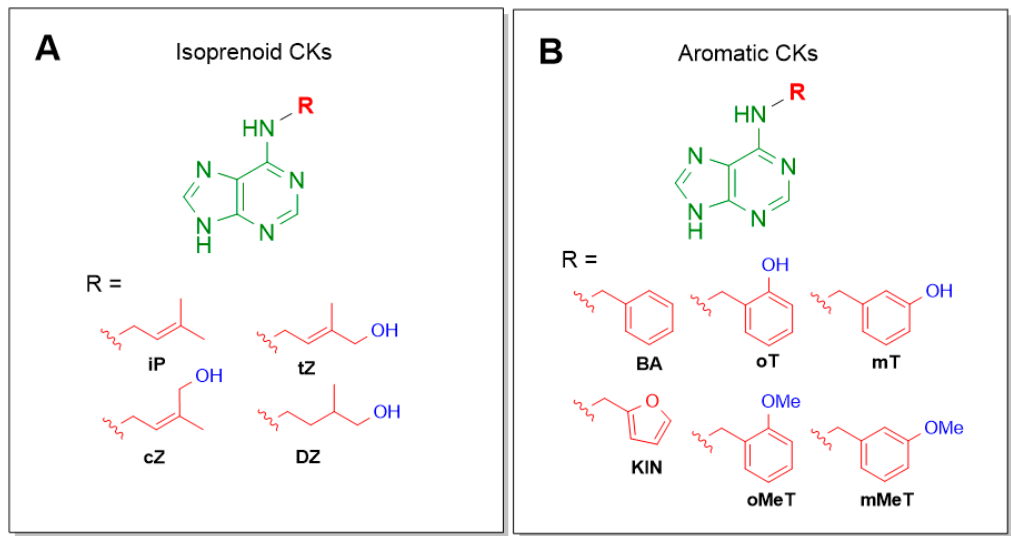
Figure 1. Names and structures of the naturally occurring cytokinins. ( A ) Isoprenoid (aliphatic) CKs: iP— N 6 -isopentenyladenine; c Z— cis -zeatin ( N 6 -(4-hydroxy-3-methyl- cis -2-buten-1-yl)adenine); t Z—